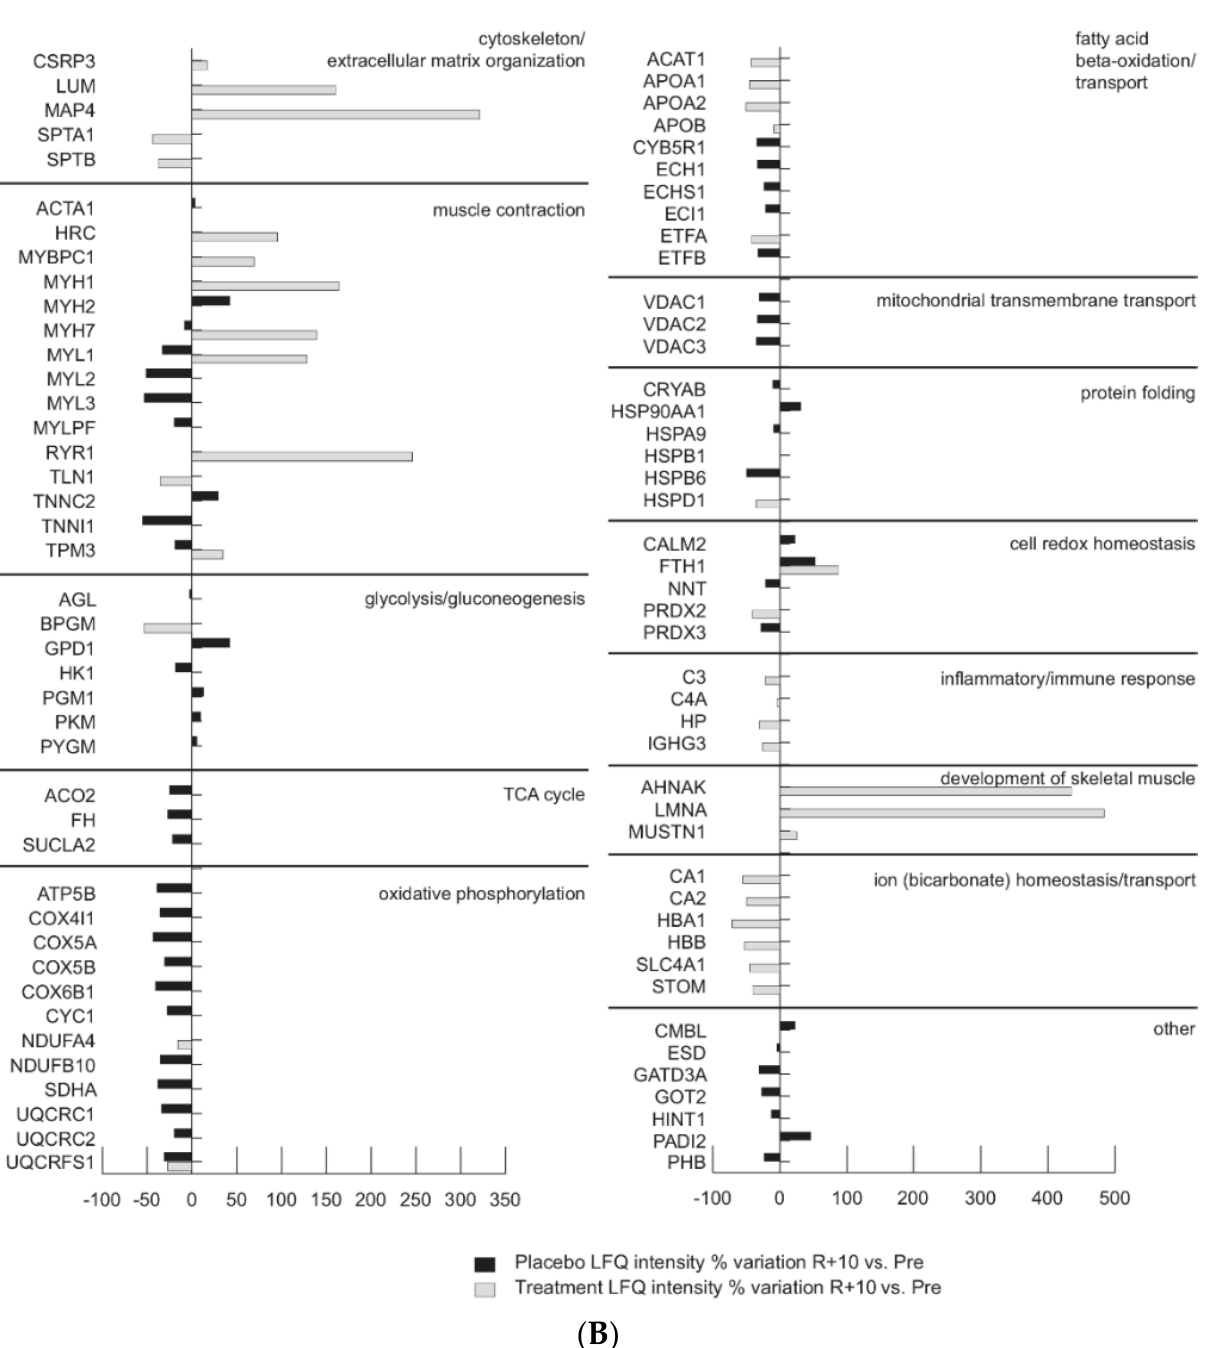
Figure 2. ( A ) Comparison of Placebo (black bars) and Treatment (gray bars) proteomic datasets in bedrest Post vs. Pre condition (LFQ intensity % variation, ANOVA and Tukey’s test, n = 5, p < 0.05). ( B ) Comparison of Placebo (black bars) and Treatment (gray bars) proteomic datasets in bedrest R+10 vs. Pre condition (LFQ intensity % variation, ANOVA and Tukey’s test, n = 5, p < 0.05). The individual variability within the group (Pre, Post, and R + 10) of differentially expressed proteins in the analyzed subjects under Placebo and Treatment is shown in Figures S1 and S2,